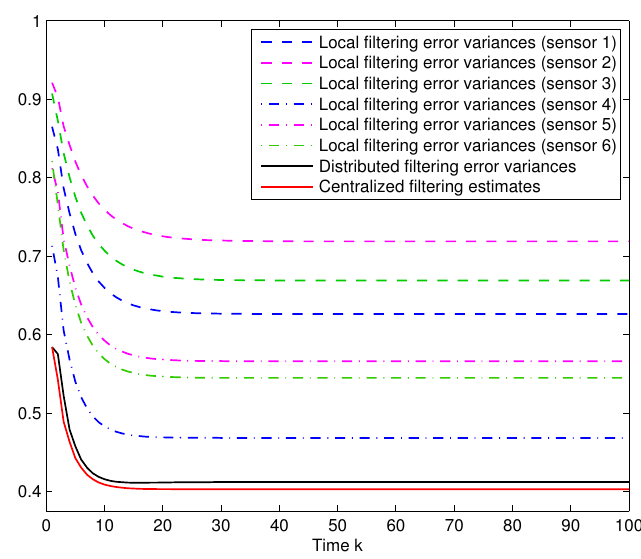
Figure 5. Filtering error variances when θ = 0.5, θ ∗ = 0.75 and γ ( i ) =